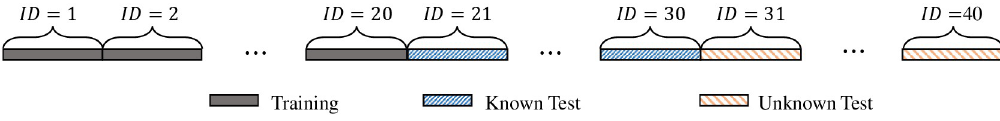
Fig 7. Illustration of splitting the data into the training, known test , and unknown test